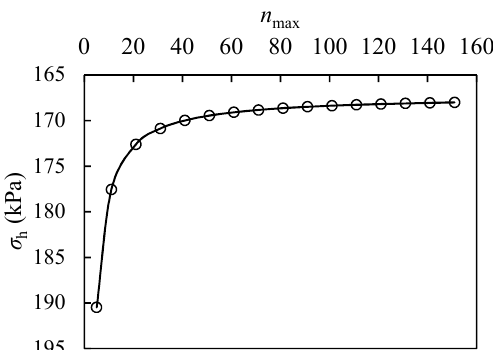
Figure 2. Variation of σ h with the value of n max obtained by calculations with the MATLAB program; calculated with H = 20 m, B = 4 m, m = 0.1 m/h, c v = 5 m 2 /h, γ w = 10 kN/m 3 , γ = 20 kN/m 3 , φ ’ = 10 ◦ and K = K a .